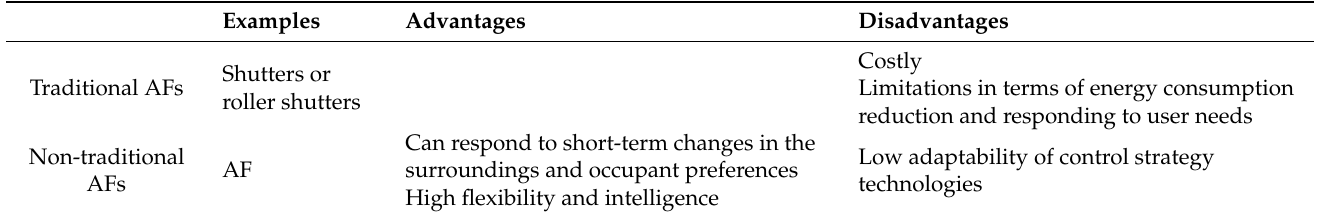
Table 2. Characteristics of